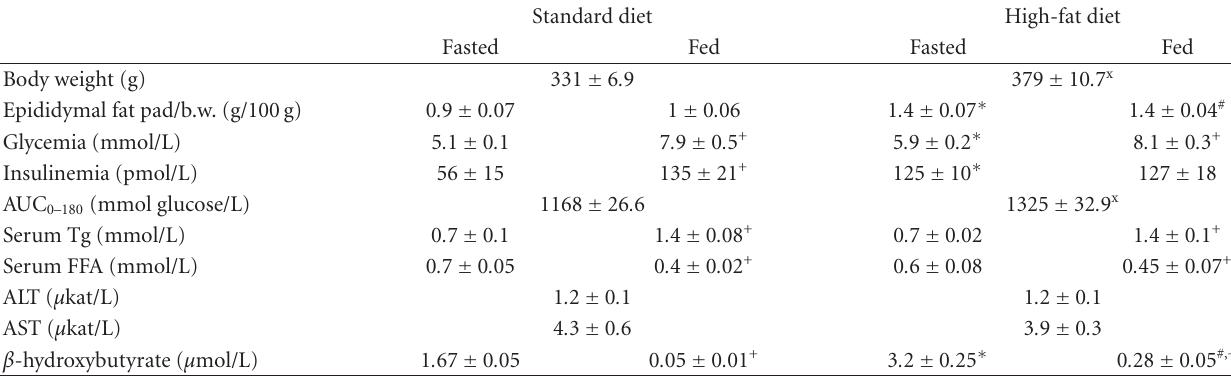
Table 1: The e ff ect of HFD on physical and metabolic parameters.